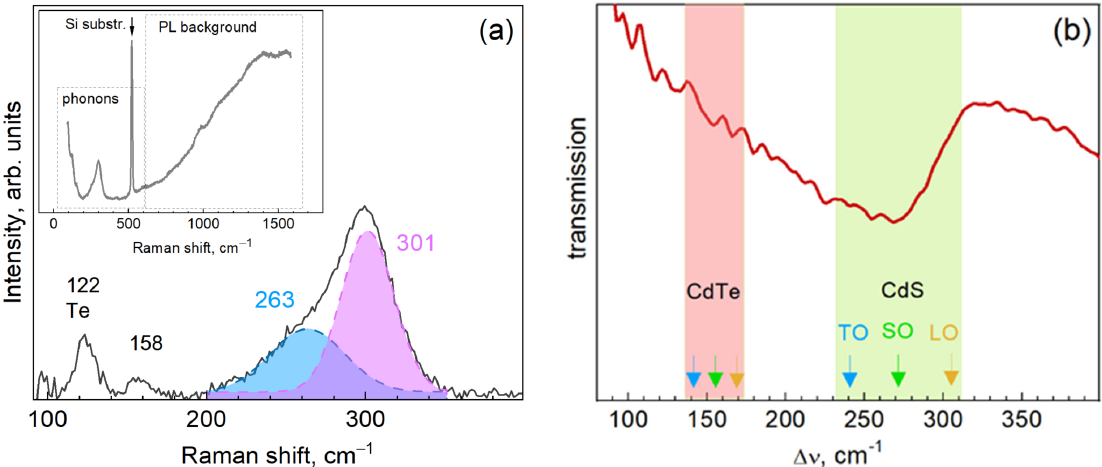
Figure 3. Representative Raman ( a ) and infrared ( b ) spectra of the CdTe-TGA NCs. For the Raman spectrum, the PL background was subtracted and the main feature fitted with two components. In the inset to ( a ), the as-measured (raw) spectrum is shown with the ranges indicated where NC phonons and PL background are expected. In ( b ), the position of the bulk TO and LO frequencies are indicated by arrows, and the range of possible SO positions by a shaded areas for CdS and CdTe.